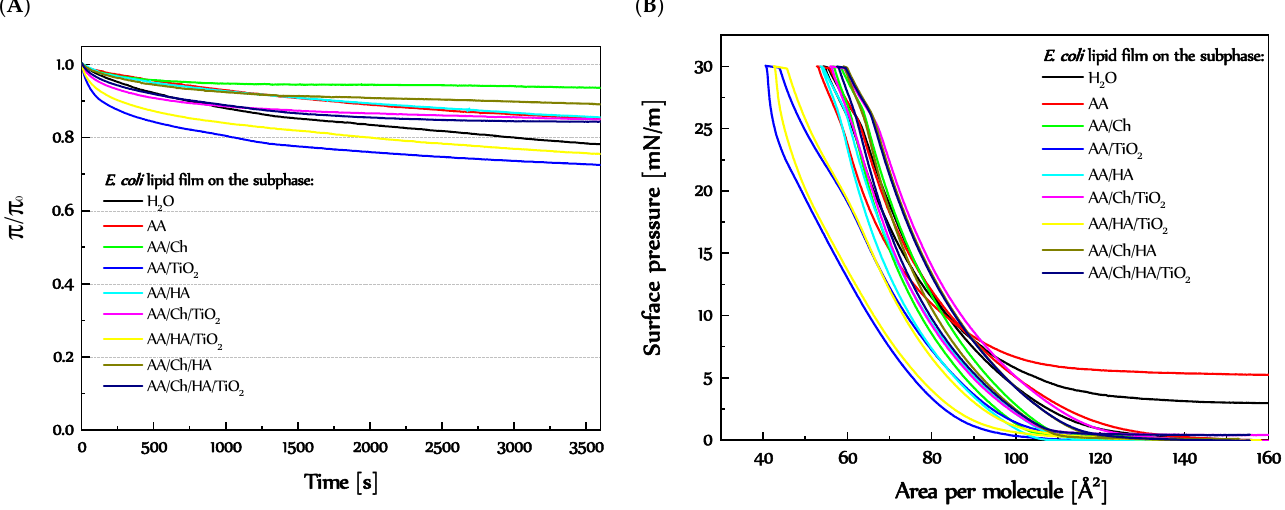
Figure 8. ( A ) π / π 0 = f(t) and ( B ) hysteresis loops (more details Figures S6 and S7) obtained by compression and decompression of the E. coli lipid monolayers on the individual subphases. 3.3.3. Thickness and Structure of the E. coli Lipid Monolayers Visualization of the E. coli lipid film (Figure 9) on the H 2 O subphase showed that at